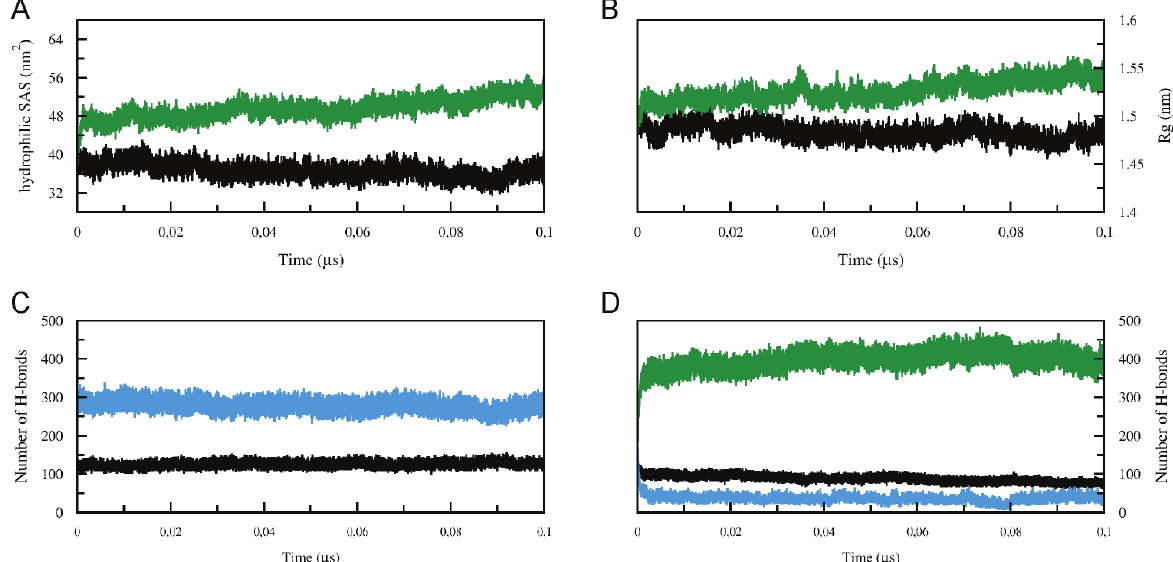
Figure 4 - MD analyses as a function of time in relation to the starting X-ray-derived structure considering the: (A) hydrophilic solvent- accessible surface (SAS) and (B) gyration radious (Rg) for Systems 3 (black curve) and 6 (green curve). Additionally, the number of protein-protein (black curve) and protein-water (light blue curve) hydrogen bonds is presented for Systems 3 (C) and 6 (D), as well as the protein-urea hydrogen bonds (green curve) in System 6